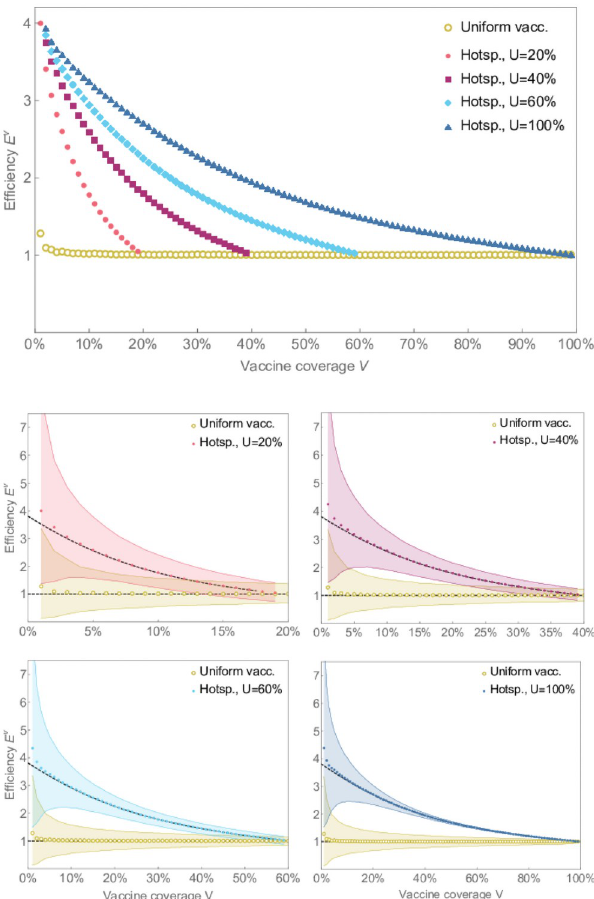
Fig 1. Efficiency of hot-spotting strategy. The efficiency for the hot-spotting strategy for R 0 = 1.5 with various app usage rates are compared with the uniform vaccination in relation to vaccine coverage. The dots represent the mean efficiency obtained from 10,000 simulations for each dot. The shaded regions show the intervals that capture 90% of all simulation results. The dashed lines in the bottom figures show the expected efficiency obtained analytically.